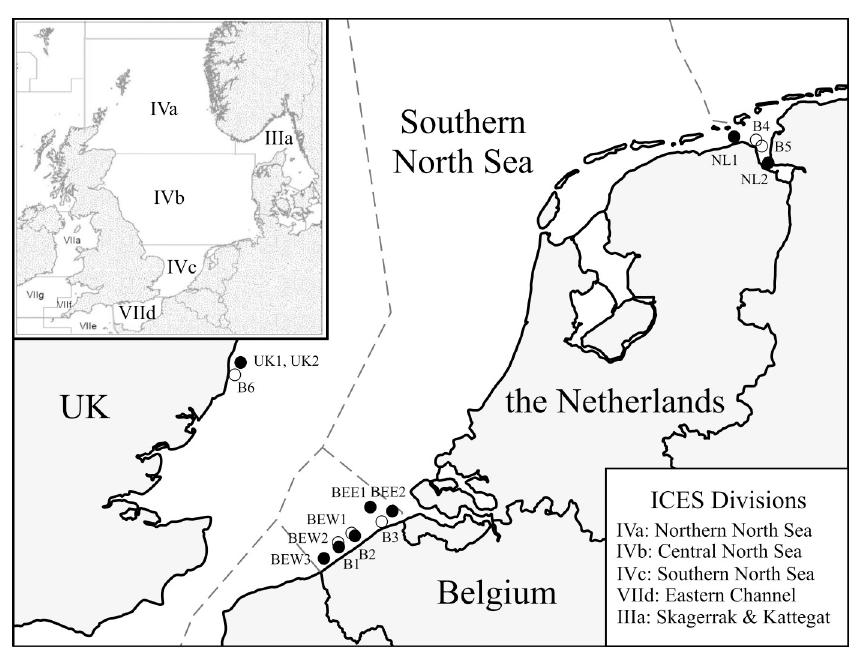
Fig 1. Distribution of the eight sampling locations along the coasts of Belgium, the Netherlands (Eems-Dollard estuary), and United Kingdom (Suffolk coast) within the southern North Sea, ICES division 4.c. Samples (N = 154) were mainly collected at the end of summer in 2013 and 2014, except for the UK samples collected in March 2016. Empty circles indicate the closest buoys to the sampled locations that were used to retrieve coastal SST data. Map modified from www.marineregions.org.